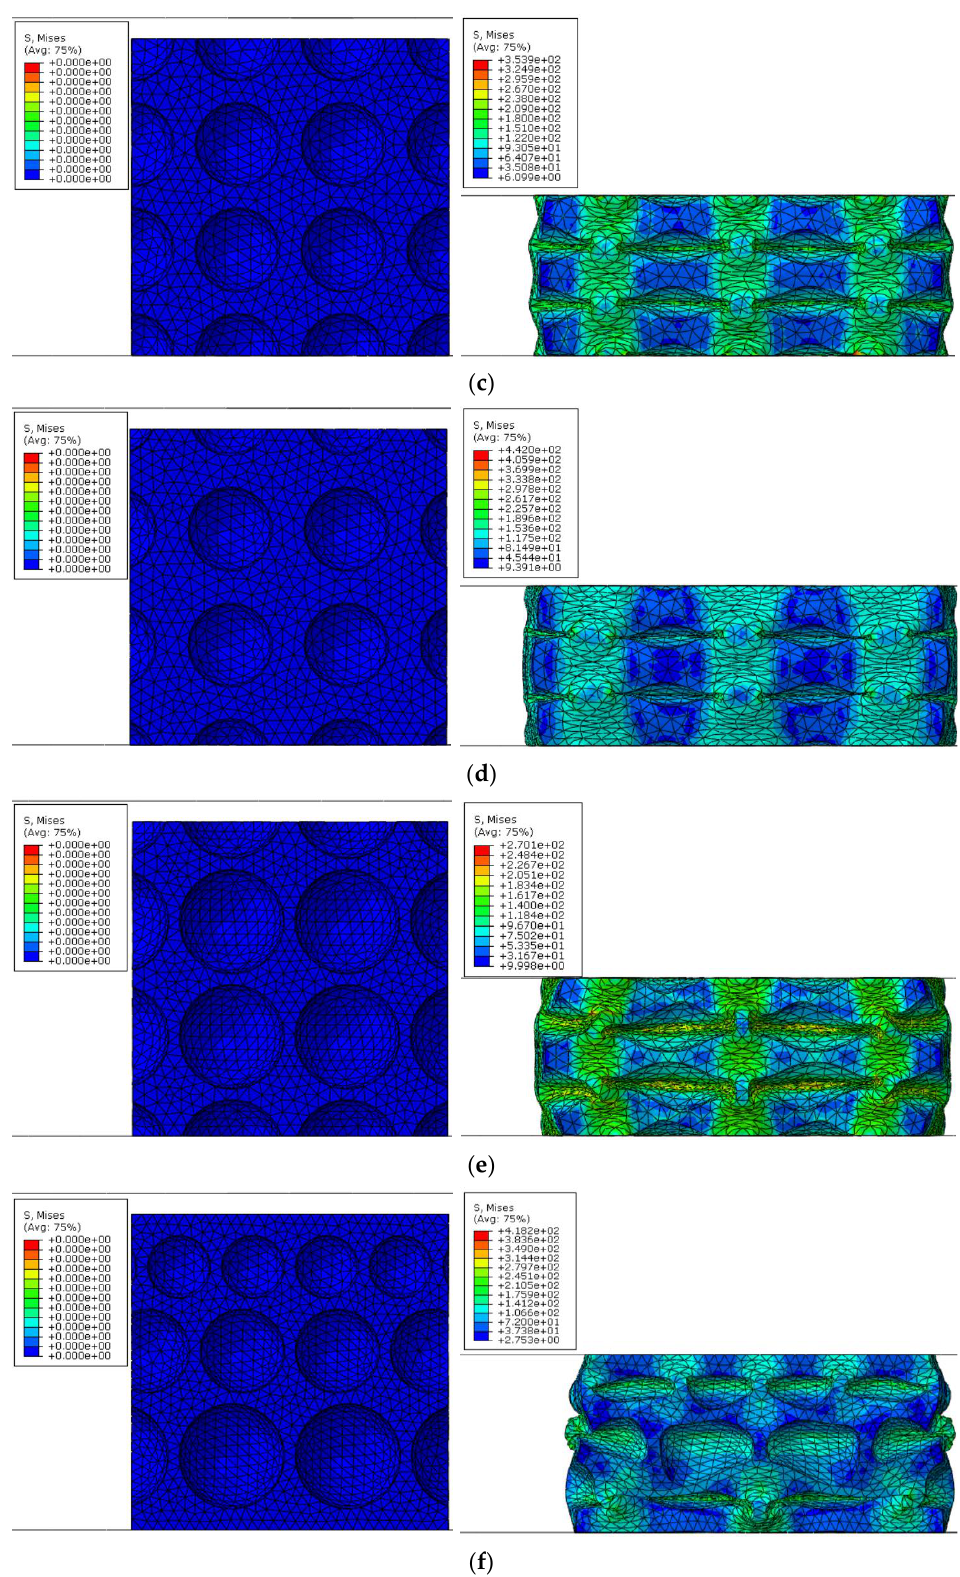
Figure 14. The deformation configuration pictures of different CCCF models at the compressive strain of zero ( left ) and 0.5 ( right ). ( a ) D (pore diameter) = 3 mm, t (wall thickness) = 0.5 mm. ( b ) D = 4 mm, t = 0.5 mm. ( c ) D = 4 mm, t = 1.0 mm. ( d ) D = 4 mm, t = 1.5 mm. ( e ) D = 5 mm, t = 0.5 mm. ( f ) Graded, t = 0.5 mm, with pore diameter D ranging from 3 mm to 5